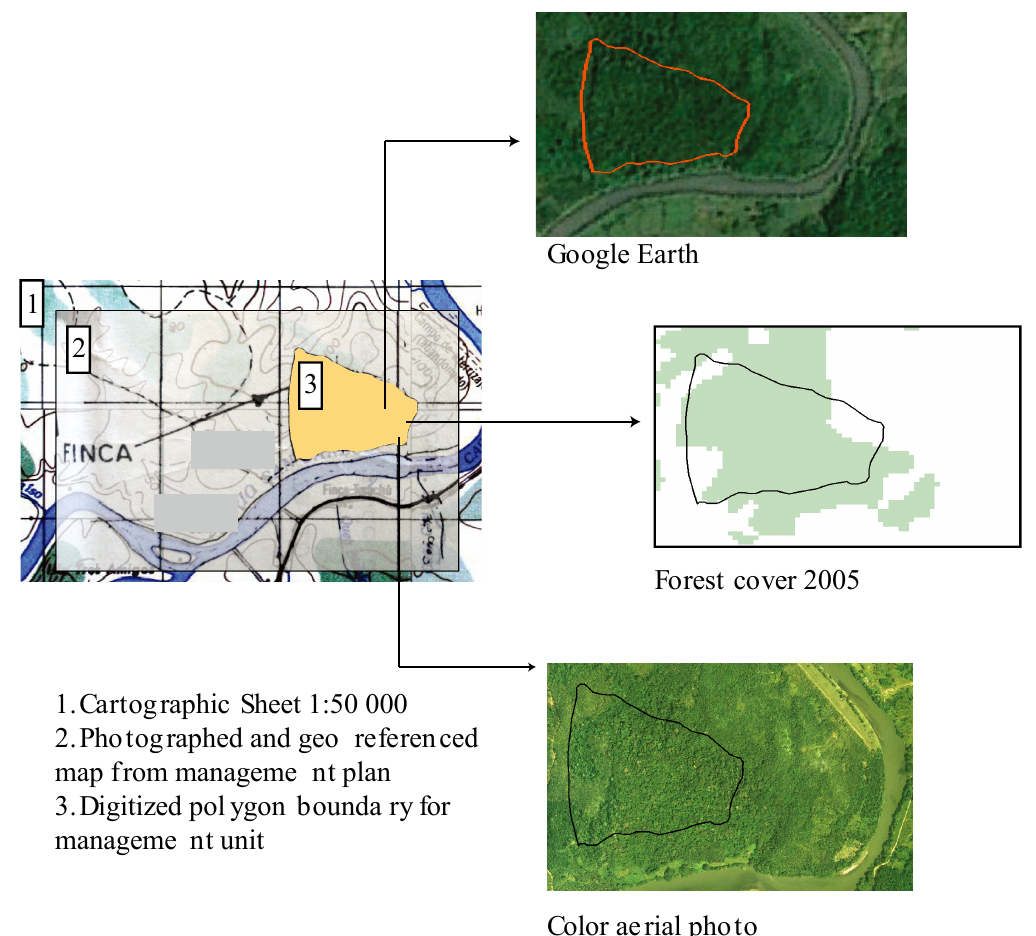
Figure 2. Process for assessing the permanence of the forest stand after selective logging. Geographic errors inherent in the coordinate transformation for Costa Rica and the on-screen digitization of archival documents were triple-checked with different datasets and distinct features on the ground when available (e.g., roads, rivers, etc .); this example is an agreement with the original management plan because the forest is still present in the management